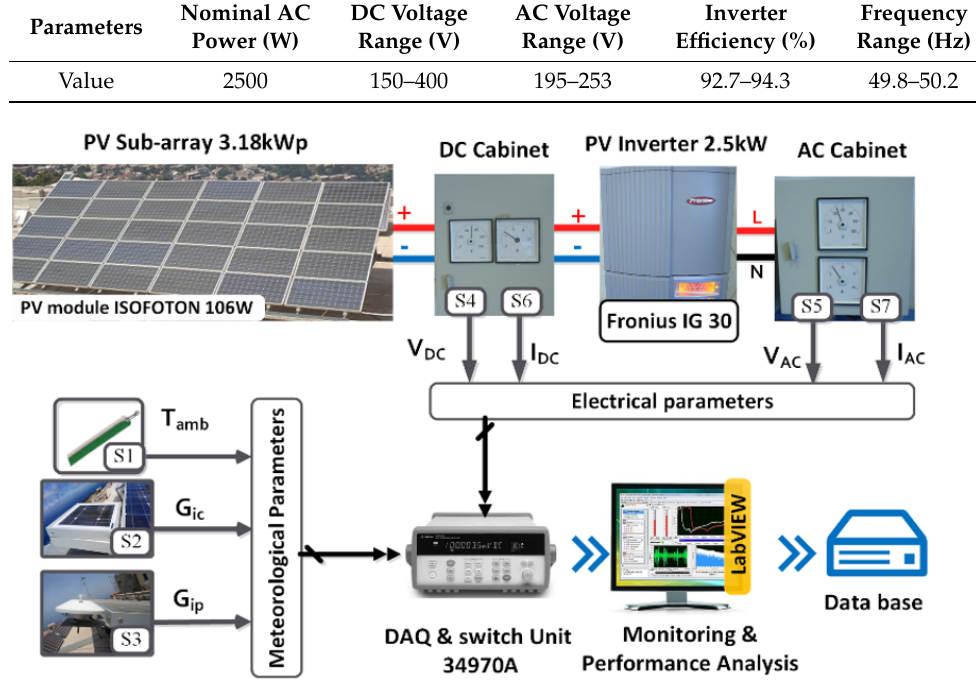
Figure 2. Synoptic diagram of the PV monitoring